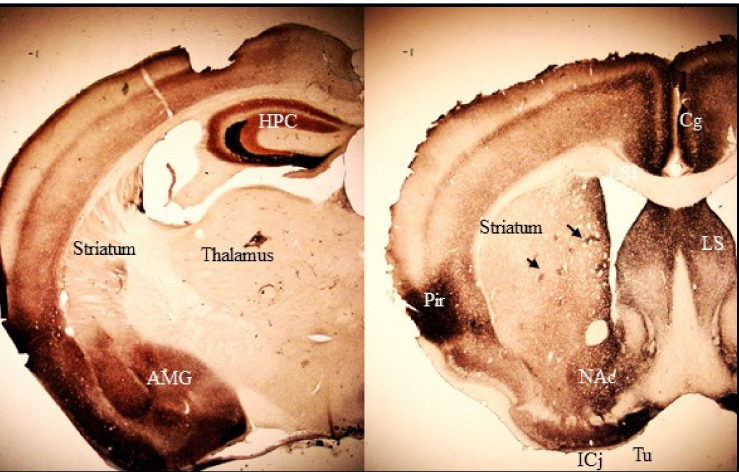
Figure 1. Photomicrographs of coronal sections of mouse brain representing synaptic Zn 2+ staining in cortico-limbic and striatal regions. The tan-brown-black staining corresponds to histochemically reactive Zn 2+ revealed with the NeoTimm staining method. Abbreviations: HPC, hippocampus; AMG, amygdala complex; Cg, cingulate cortex; Pir, piriform cortex; LS, lateral septal nucleus; NAc, nucleus accumbens; ICj, island of Calleja; Tu, olfactory tubercle. Black arrows indicate striatal zinc-positive